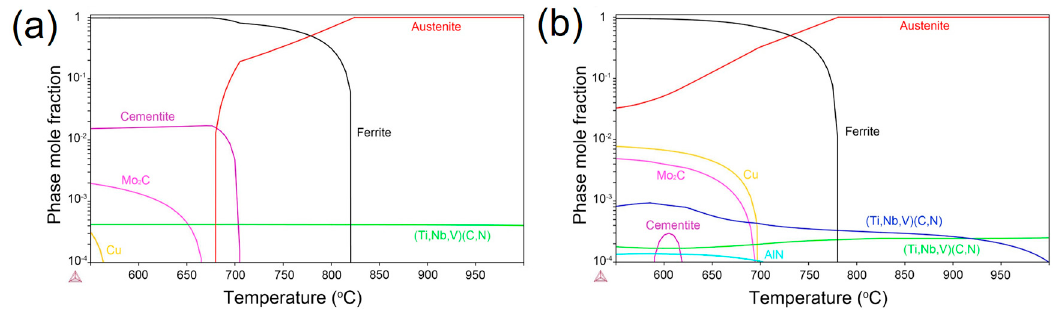
Figure 13. Equilibrium phase fractions as a function of temperature for ( a ) S690Q steel and ( b ) NiCu steel.